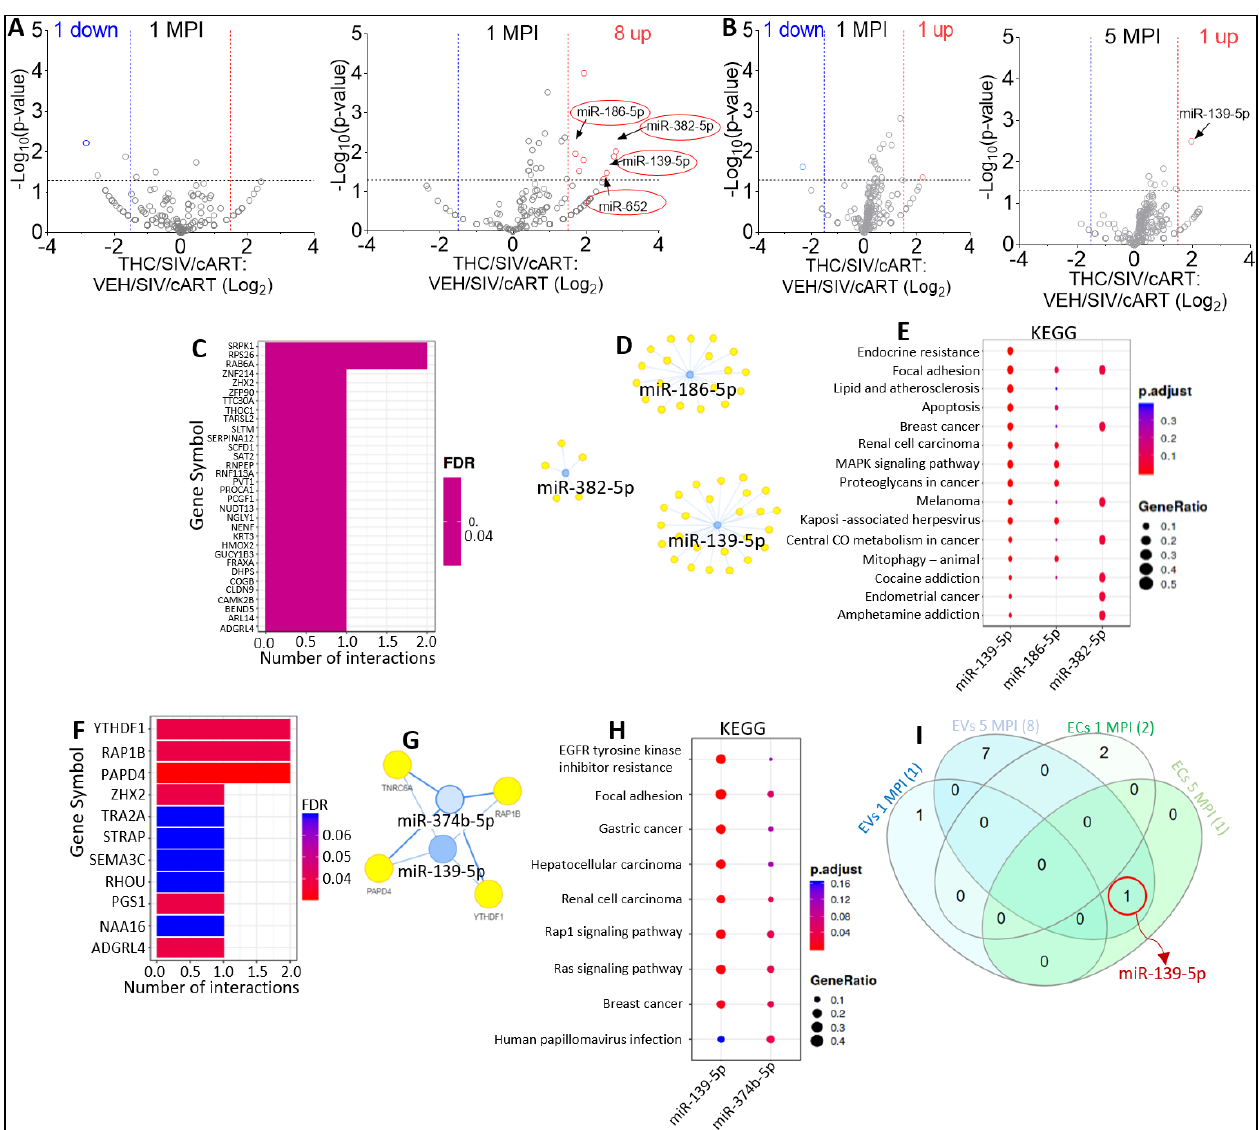
significantly downregulated at 1 MPI and 5 MPI. ( G ) Visualization of miRNA-target interaction network for miR-95-3p. The blue circles represent the miRNAs, while the target genes are represented by the yellow circles. Pathways are represented by blue lines. ( H ) Dot plot of functional enrichment analysis for target genes of miR-95-3p. Color of dots represent adjusted p-values (FDR) and size of dots represents gene ratio (number of miRNA targets found enriched in each category number of total genes associated with that category. ( I ) Venn diagram comparing significantly modulated miRNAs in the EVs and ECs at MPI and 5 MPI. Red circle indicates miRNA (miR-335-5p) that was found to be significantly downregulated at 5 MPI in both EVs and ECs. ( J ) Visualization of miRNAtarget interaction network for miR-335-5p. ( K ) Dot plot of functional enrichment analysis for miR-335-5p Color of dots represent adjusted p-values (FDR) and size of dots represents gene ratio (number of miRNA targets found enriched in each category number of total genes associated to that category.